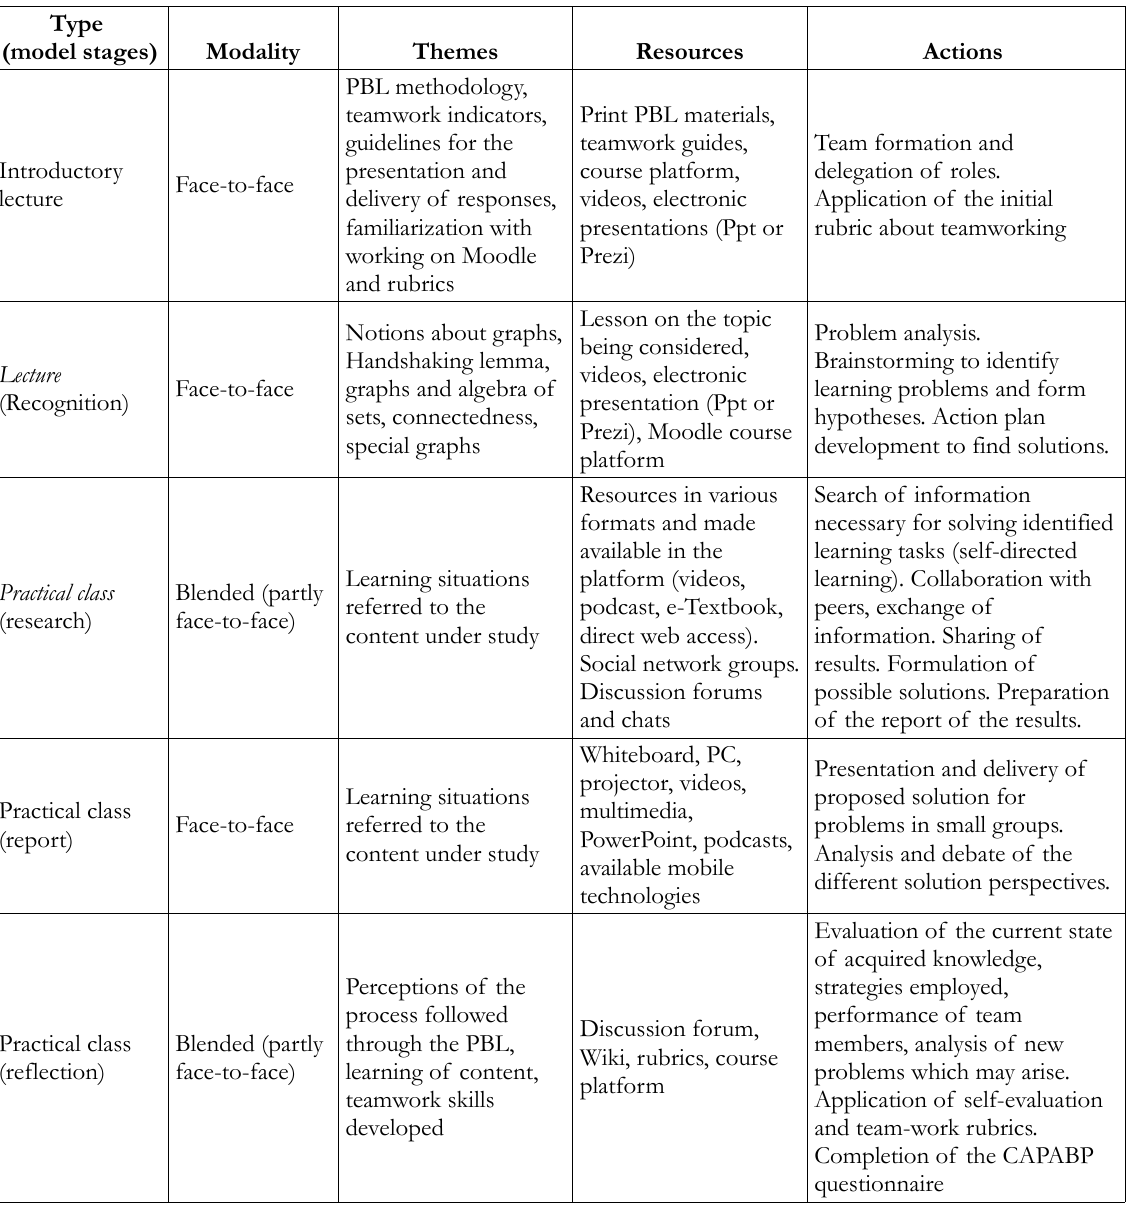
Table 1. Distribution of the consideration of learning content in each sub-theme according to the PBL model employed (Adapted from “Problem-Based Learning in Multimodal Learning Environments: Learners’ Technology Adoption Experiences (Ioannou et al., 2016))